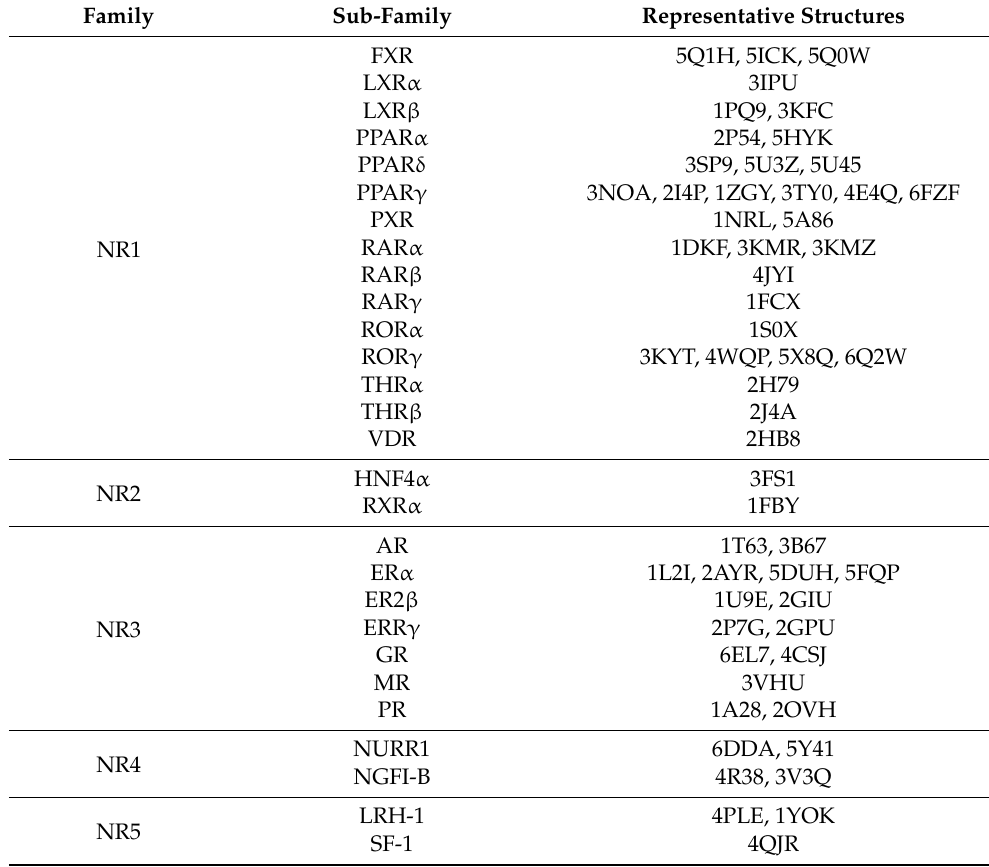
Table 2. List of the representative structures for each nuclear receptor, extracted from the cluster analysis. Family Sub-Family Representative Structures